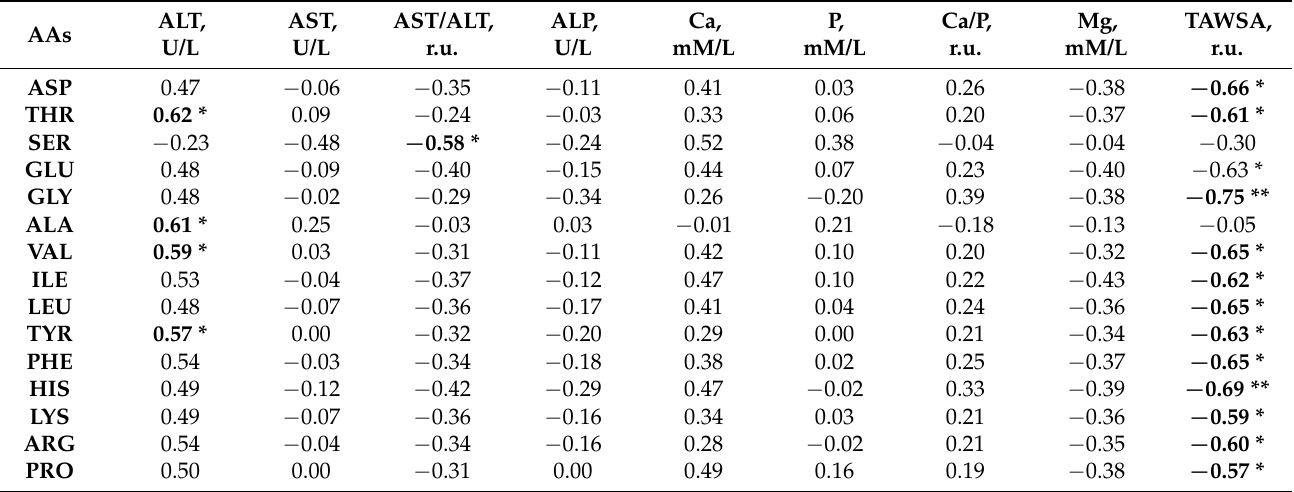
Table 9. The correlation coefficients between all obtained amino acids and the major biochemical parameters of the blood serum of Duroc pigs of the group 4 (90 days): ALT, alanine aminotransferase; AST, aspartate aminotransferase; ALT/AST, alanine to aspartate aminotransferases’ ratio; Ca, calcium; P, phosphorus; Ca/P, calcium to phosphorus ratio; Mg, magnesium; TAWSA, total amount of the water-soluble antioxidants (n =